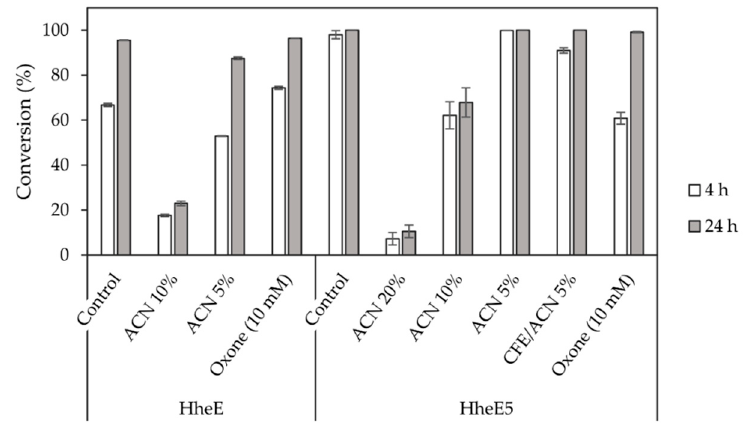
Figure 3. Epoxide ring opening catalysed by HheE (using 10 mM racemic epoxide 2 ) and HheE5 (using 10 mM racemic epoxide 5 ) using whole cells (60 g/L wet cell weight) or cell-free extract (CFE, 9.2 g/L total protein content) and NaN 3 (40 mM) in the presence of acetonitrile (ACN) and Oxone © , components of the Shi epoxidation reaction. All reactions were performed in duplicate.